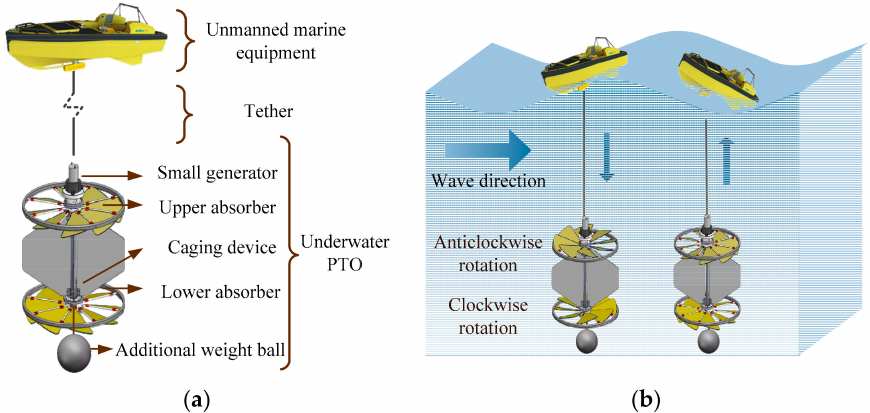
Figure 3. Rigid blade WEC: ( a ) Conceptual design; ( b ) Working